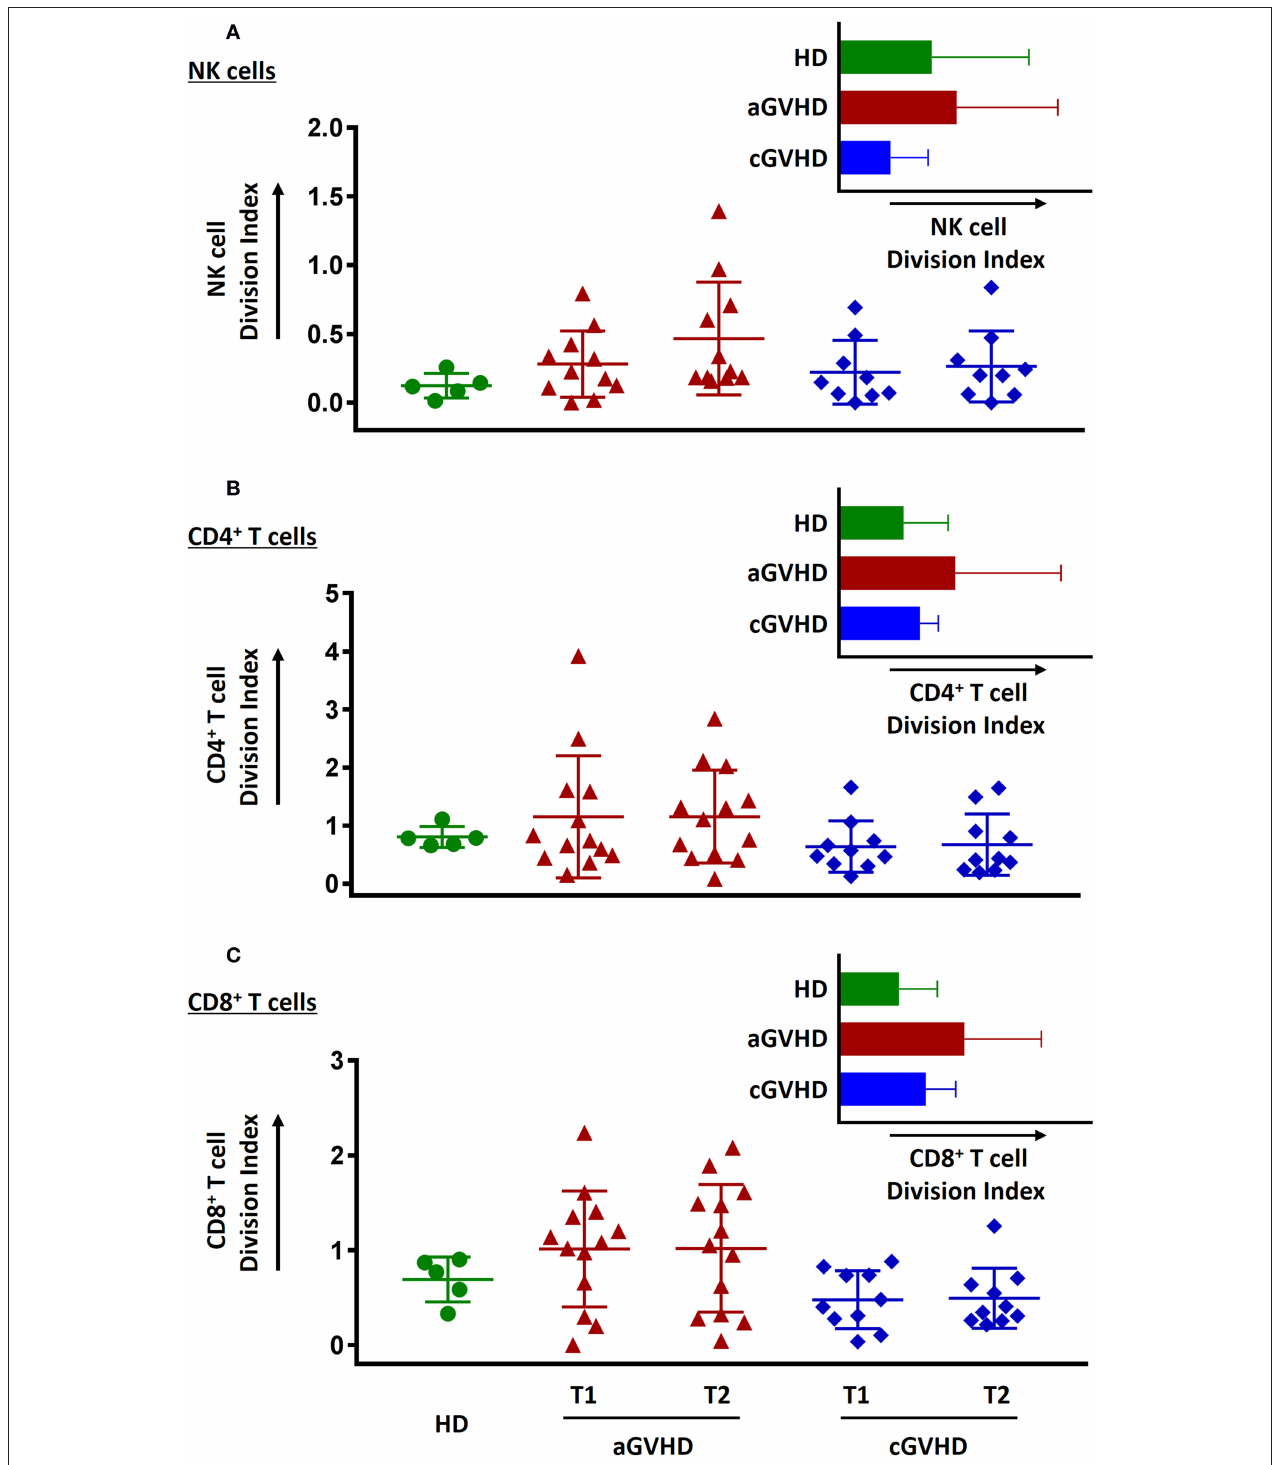
FIGURE 10 | Effect of ECP on cell proliferative function. The proliferative capacity of NK cells (A) , CD4 + T cells (B) , and CD8 + T cells (C) was evaluated using CFSE staining. None of them could be hampered by ECP therapy. All the proliferation assays were performed with 11 samples from aGVHD patients, excluding the samples from patient #5, #6, #8, #10, and #11 due to the limited cell number of samples, nine samples from cGVHD patients, excluding the samples from patient #17, #18, #19, #21, #22, #25, #26, #27, and #31 due to the limited cell number of samples, and five HDs.